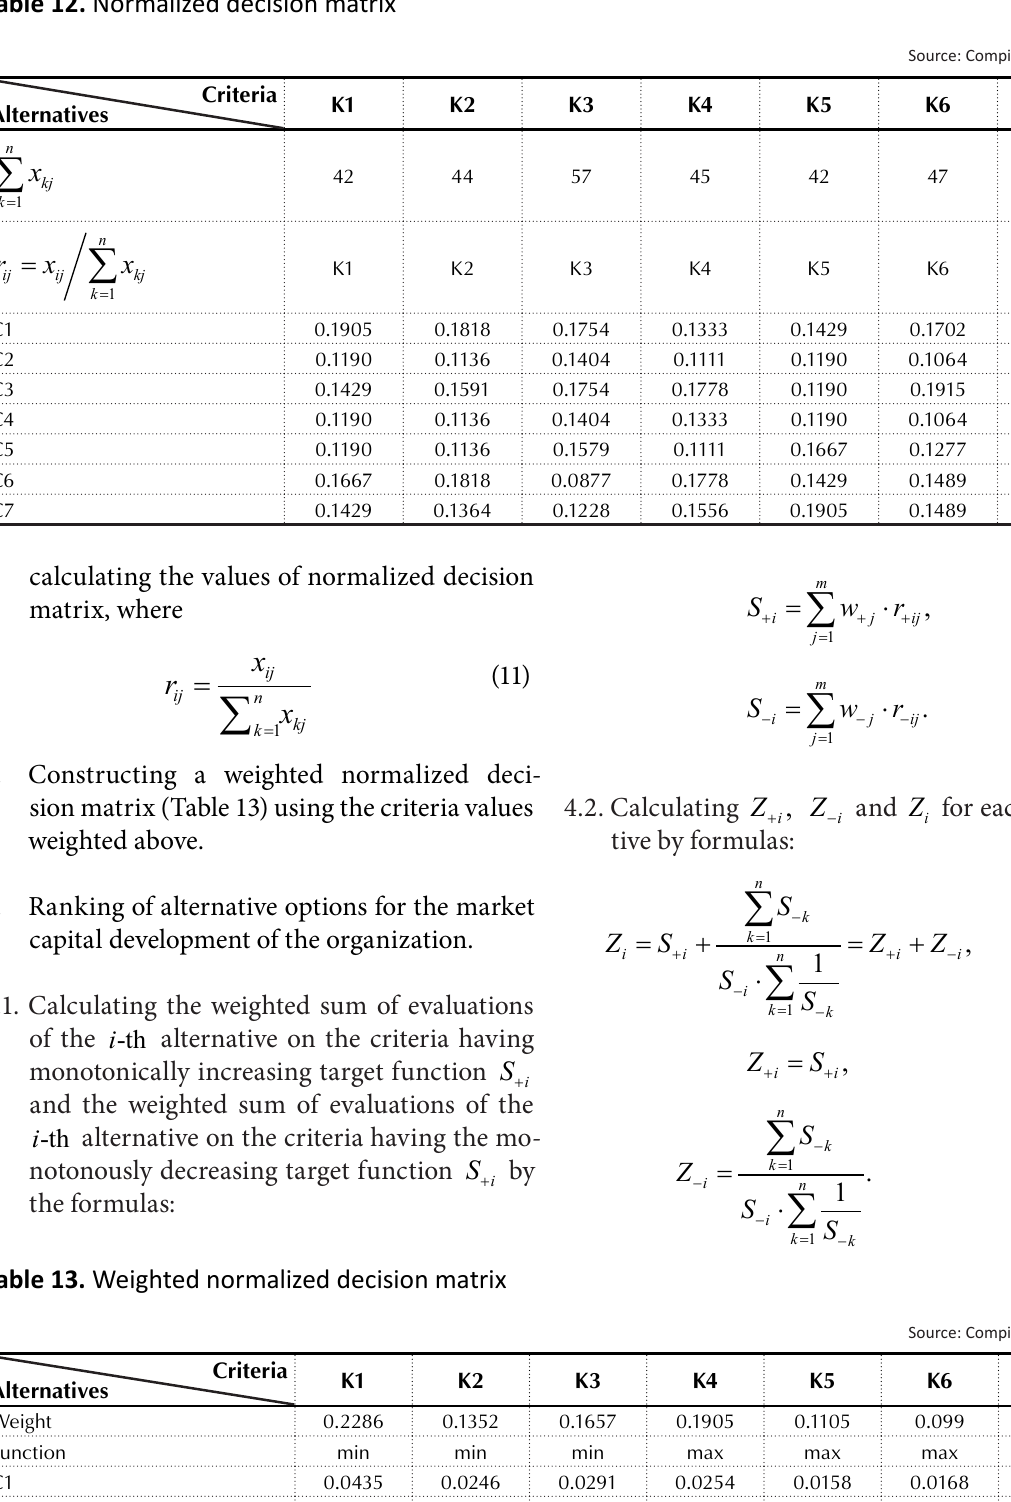
Table 12. Normalized decision matrix